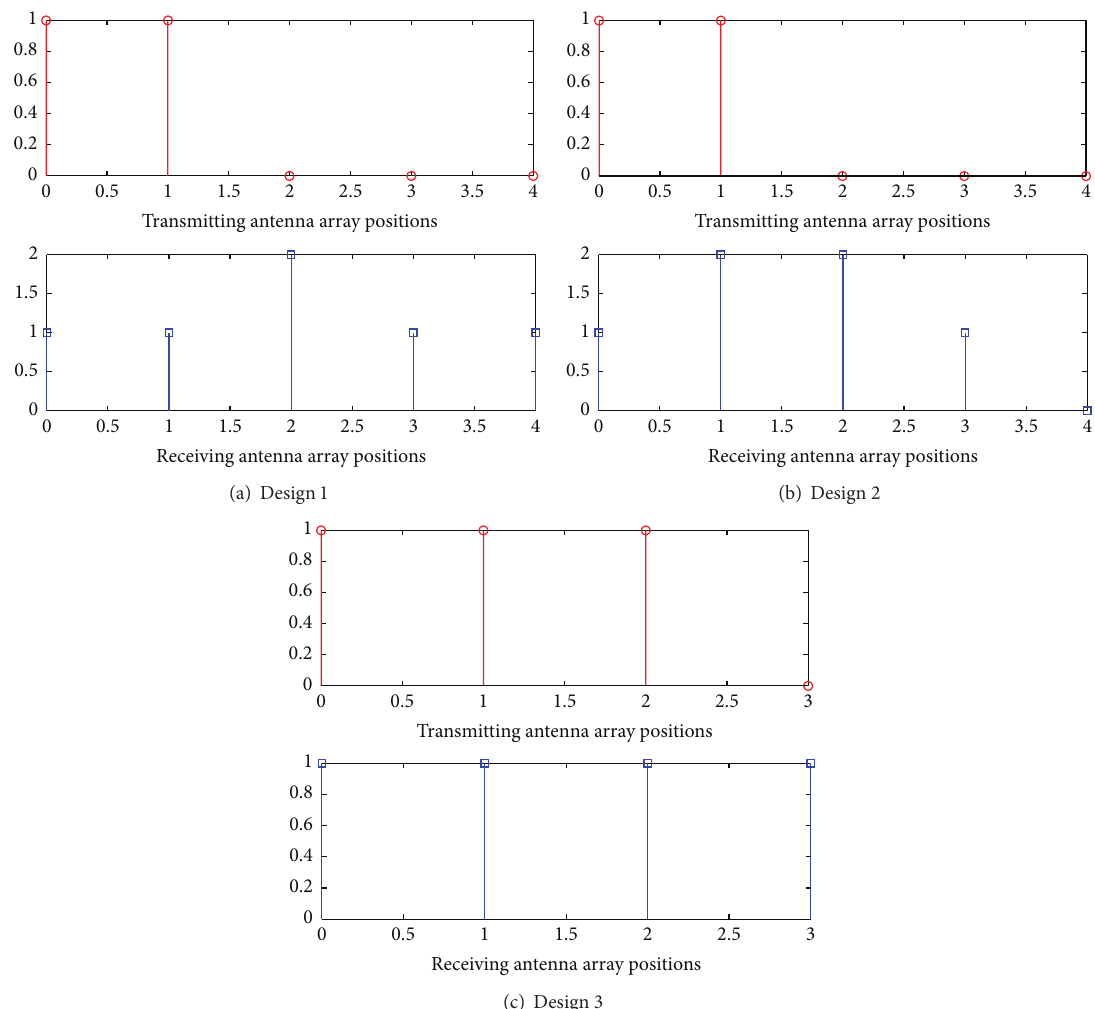
Figure 7: Designs of NSK polynomial factorization.